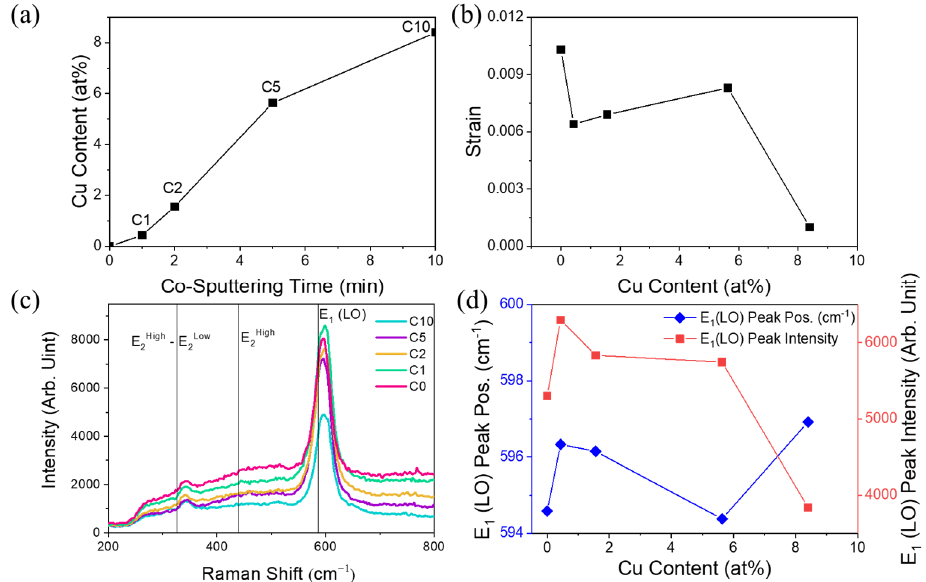
Figure 3. ( a ) Cu contents as a function of Cu co-sputtering time. ( b ) Crystal strain of each thin films obtained using Williamson-Hall method. ( c ) Raman spectra of each sample. Three reference Raman − E Low peaks, E High at 331 nm, E High at 438 nm, and E 1 ( LO ) at 590 nm, are indicated as vertical lines. ( d ) Peak position (blue) and intensity (red) of E 1 ( LO ) peak for each sample.